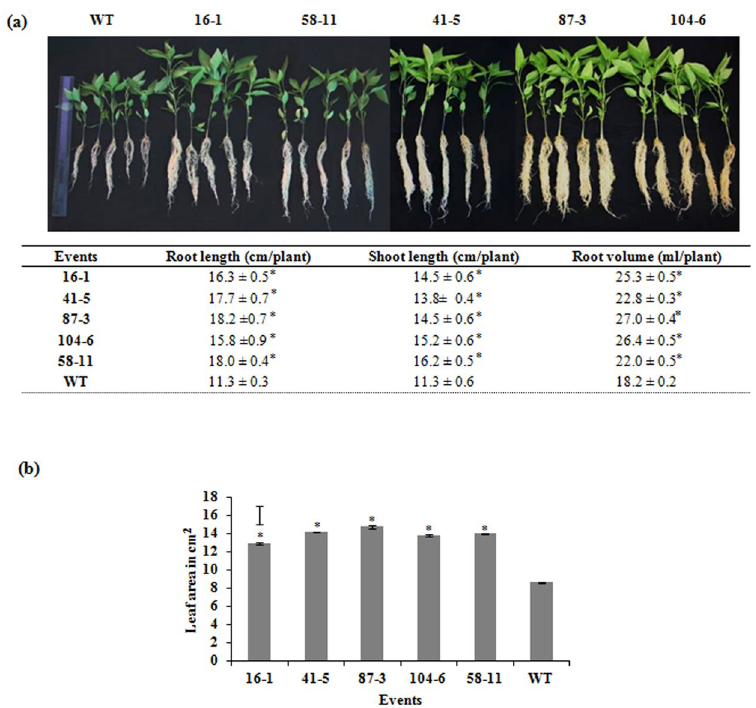
Figure 2. Morphometric evaluation of transgenic events under non-stress conditions. ( a ) Comparison of growth parameters (root length, shoot length and root volume) in the transgenic events (T 3 ) and WT, 40 DAS under well-watered greenhouse conditions; ( b ) leaf area (cm 2 ) in the transgenic events compared to WT. (Bars in the graph indicate LSD value at P < 0.05; ( * ) indicates significant differences at P < 0.05; ( ** ) indicates significant differences at P <